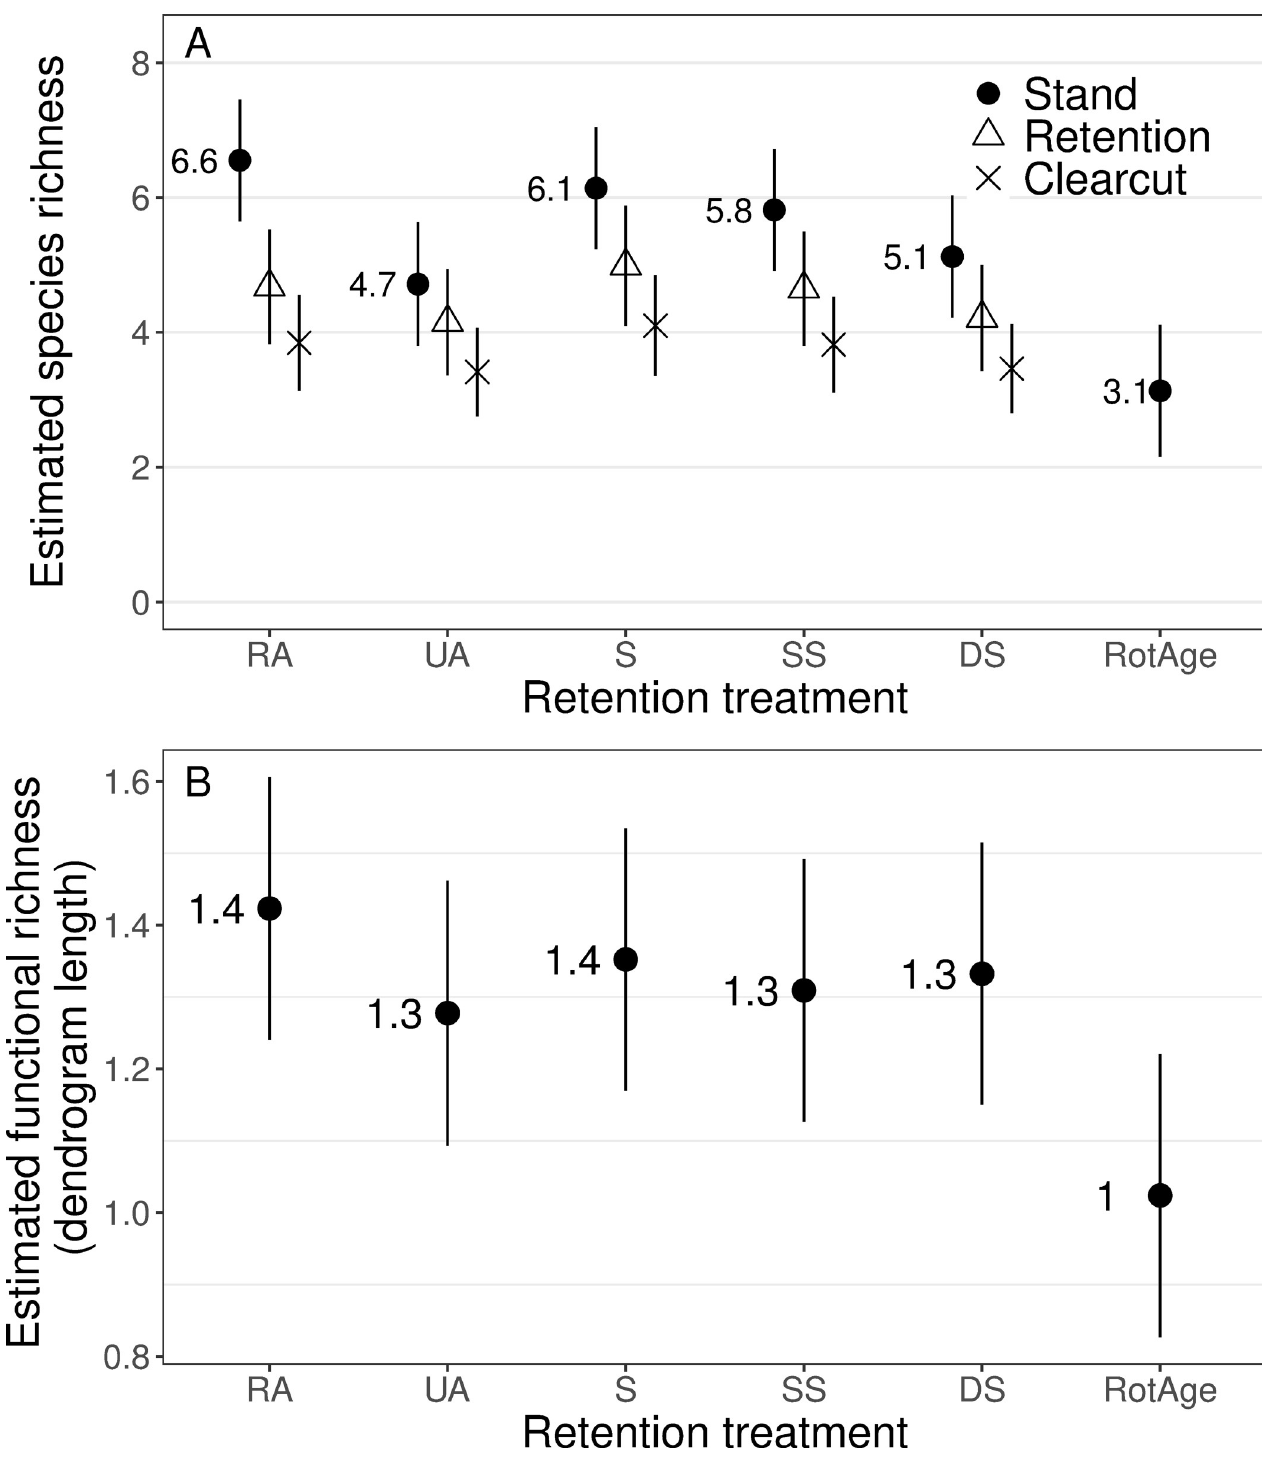
Fig 4. (a) Species richness estimates at the stand-scale (black circles), within retention (white triangles) and within clearcuts (Xs), and (b) stand-scale functional richness estimates, for each structural retention treatment, northwest Oregon and southwest Washington, USA, 2017–2019. Estimates represent unconditional predictions from mixed-effects models for 2018. RA = Riparian Aggregated, UA = Upland Aggregated, S = Split, SS, Split with Snags, and DS = Dispersed with Snags.